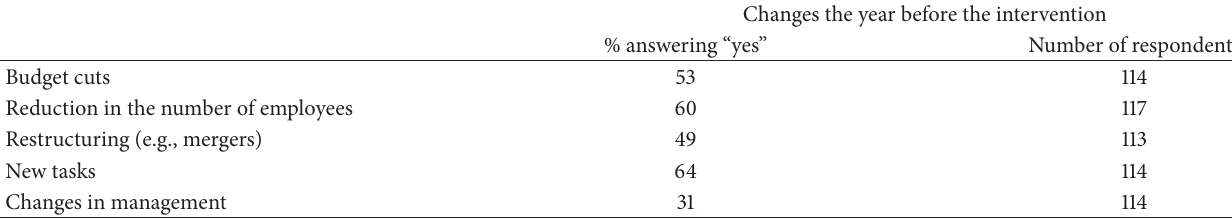
Table 2: Managers’ reports of changes at the workplace the year before the